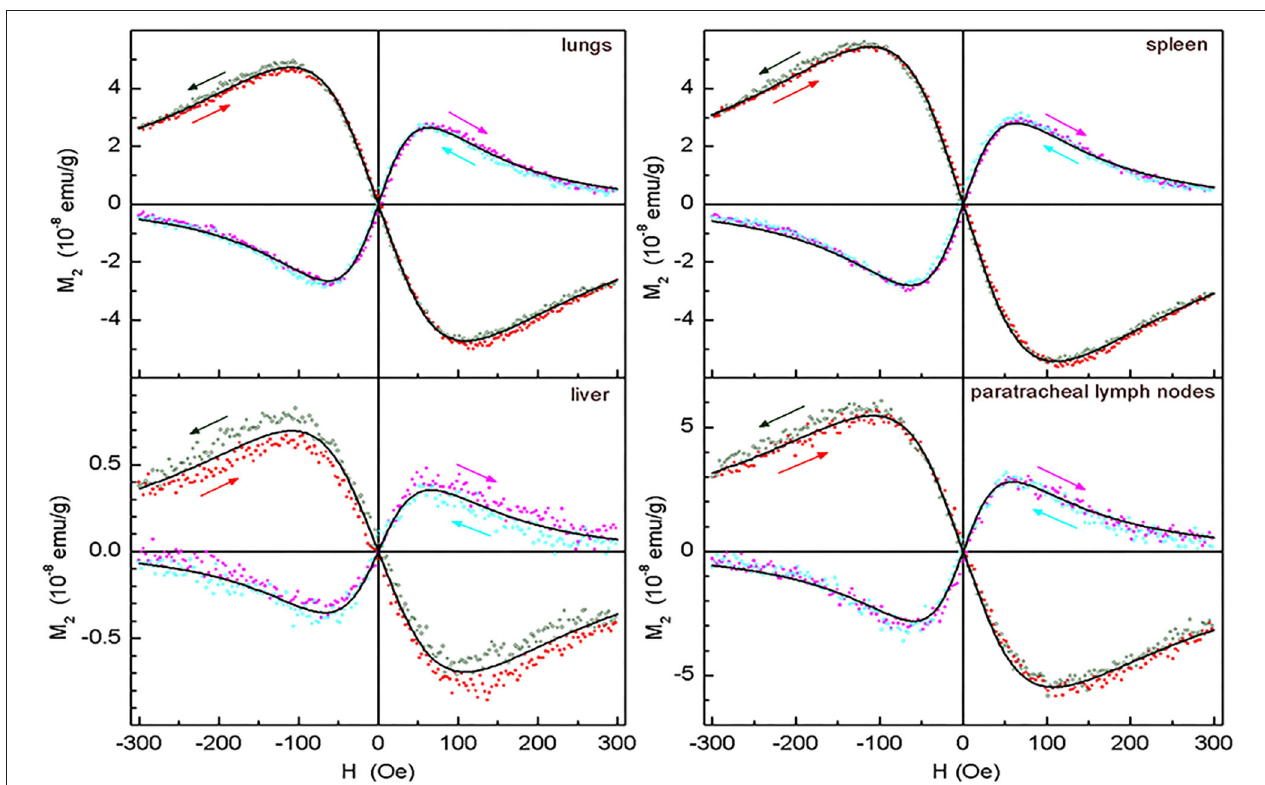
FIGURE 9 | Real and imaginary parts of the non-linear magnetic response as functions of the dc magnetic field direct (filled symbols) and reverse (open symbols) scans with F sc 8Hz, with their best fits for lungs, spleen, liver, and paratracheal lymph nodes following 2 days after intravenous injection of SPION-labeled MSCs. = Only every 10th experimental point is shown. Obtained parameters are presented in Table 1